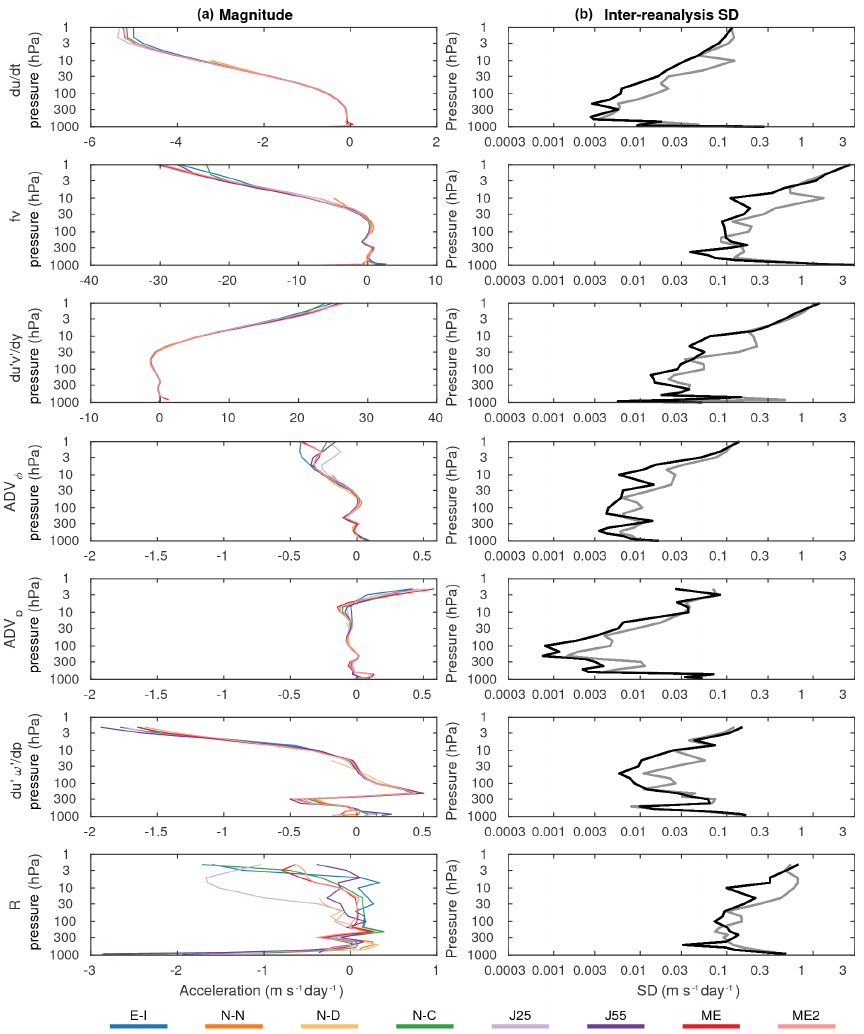
Figure 6. Vertical profiles of each term in the momentum equation averaged from lags − 5 to 0 days during SSW events. All variables are averaged between 45 and 85 ◦ N. Individual reanalyses are shown to the left and the inter-reanalysis standard deviation is shown to the right on a logarithmic scale. The latter is shown for all reanalyses (grey) and the LRE members (black). All quantities are expressed in units of ms − 1 day − 1